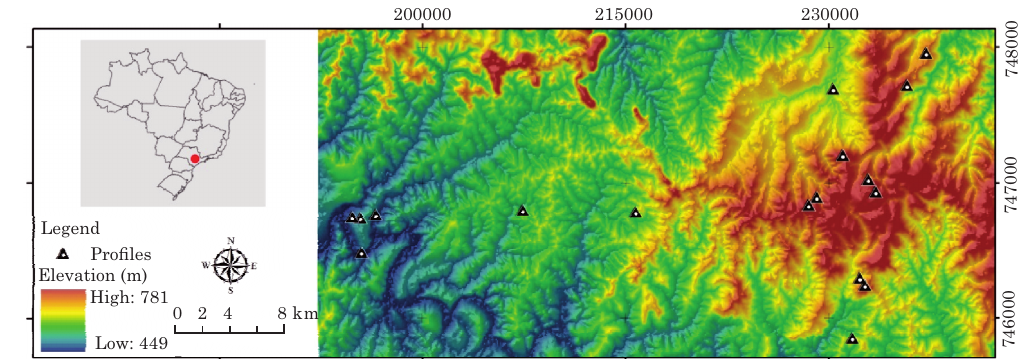
Figure 2. Profile location and landscape elevation in the survey